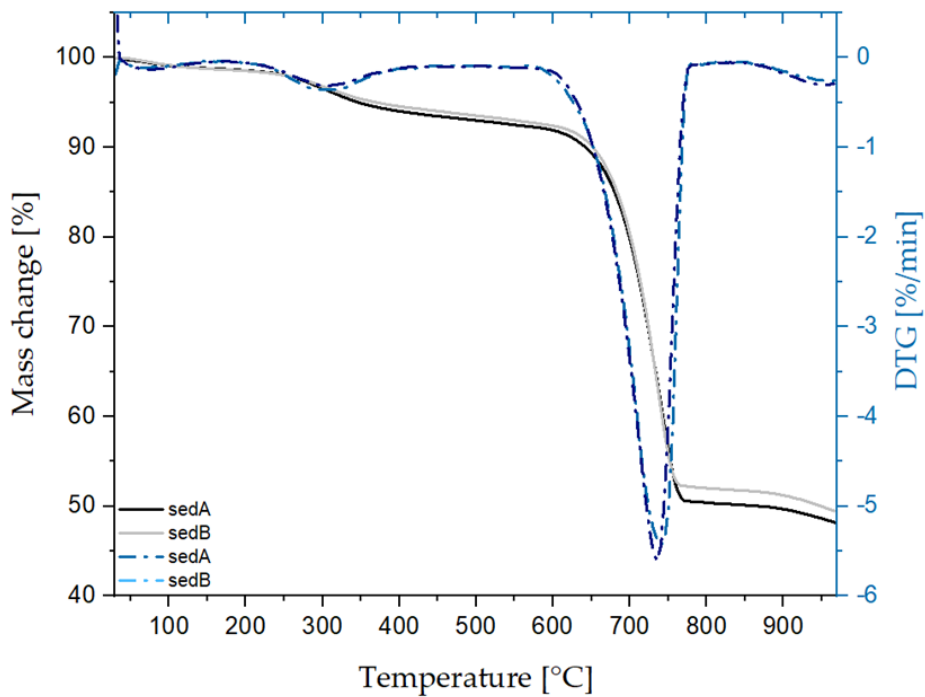
Figure 4. Thermogravimetric and Derivatographic Curves of the Sediments. Table 4. Thermal decomposition of raw deposits.